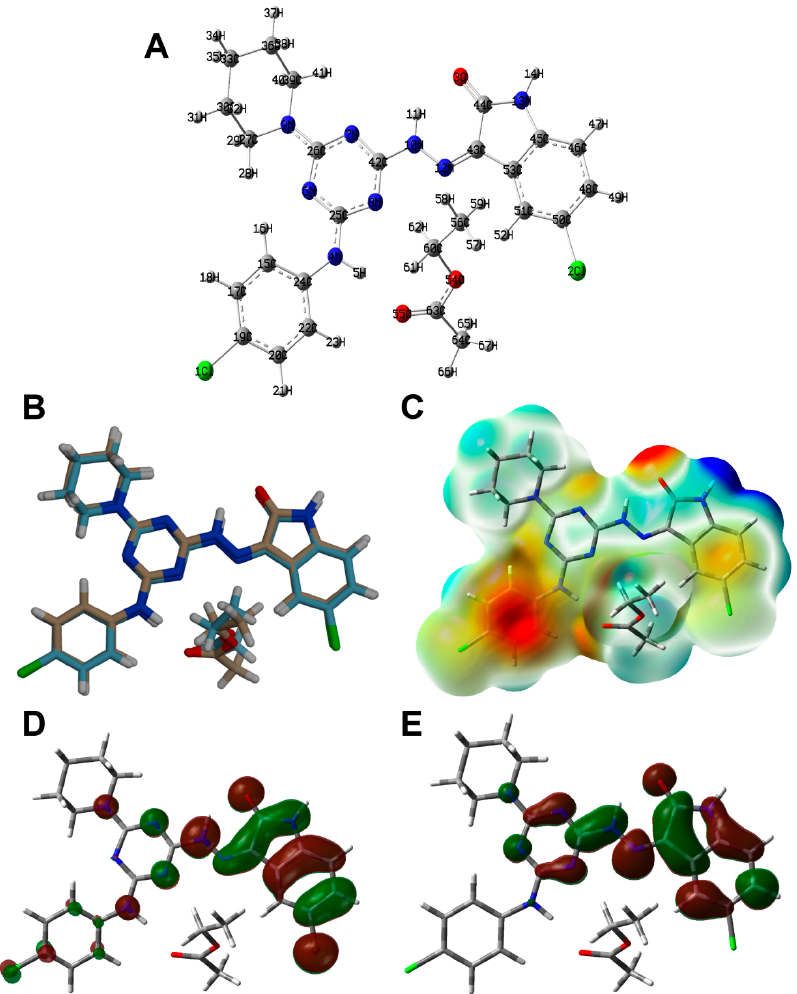
Figure 8. Optimized geometry ( A ), overlay with the X-ray geometry ( B ), MEP ( C ), HOMO ( D ) and LUMO ( E ) of 6c .